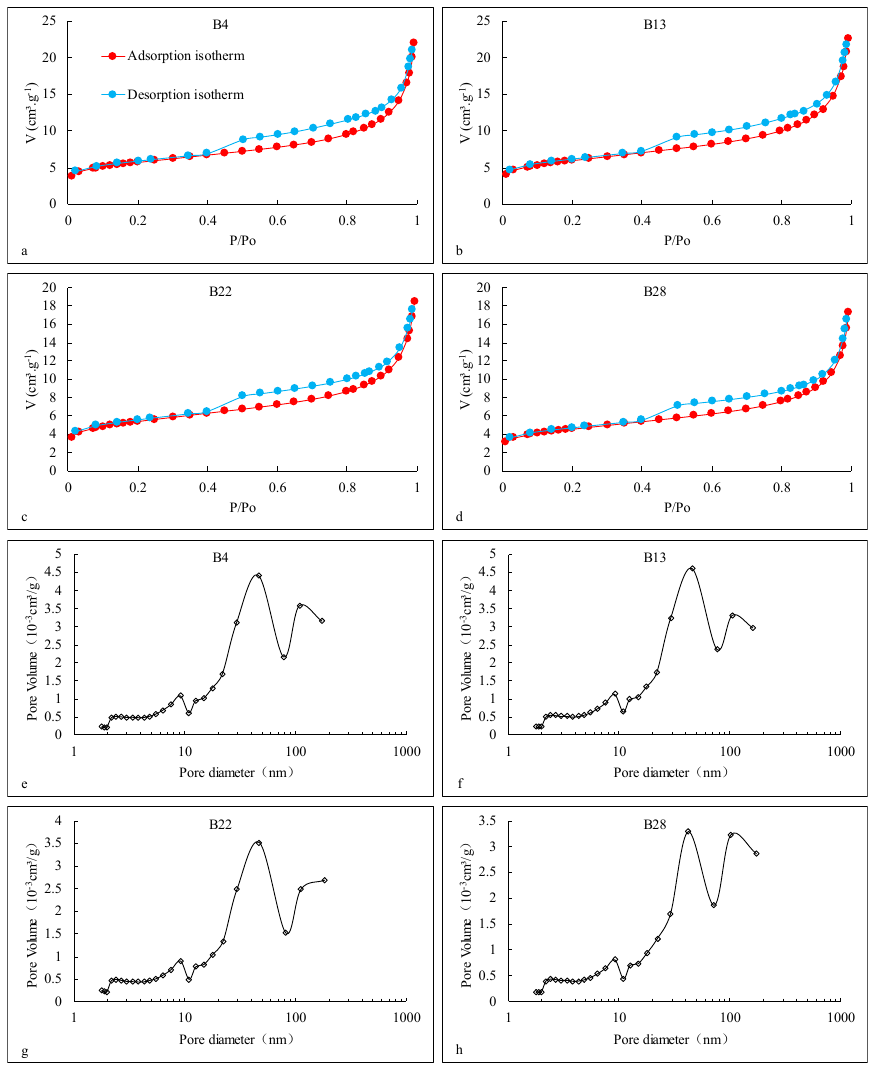
Figure 8. ( a – d ) Low-pressure N 2 adsorption–desorption isotherms of four of the Xinkailing shale samples; ( e – h ) representative pore-size distribution from the studied samples.